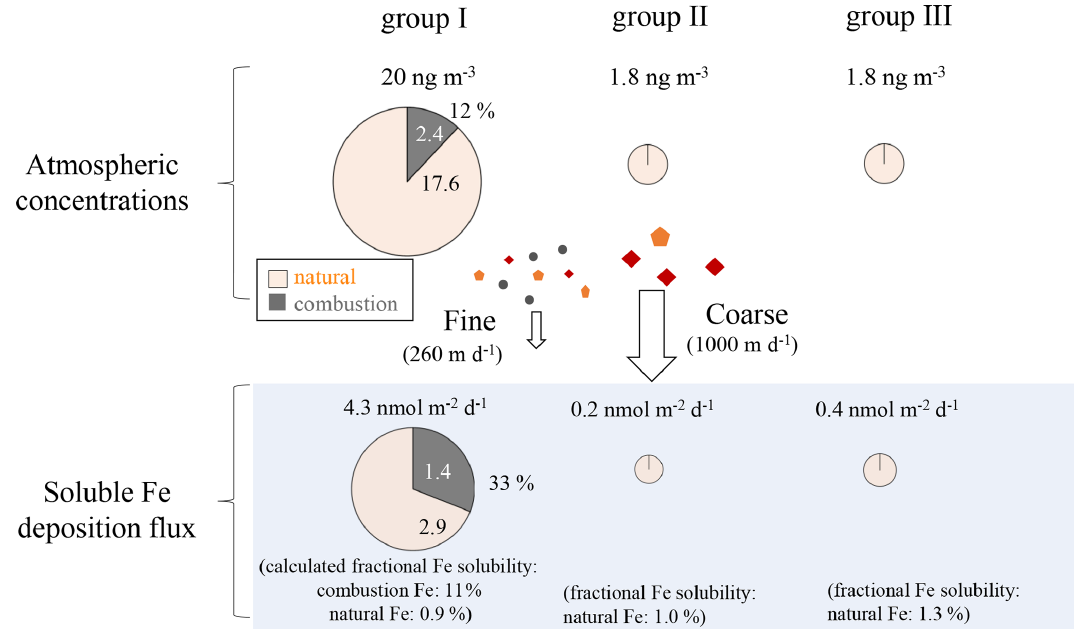
Figure 11. Summary of the contribution of combustion and natural Fe to atmospheric aerosols and soluble Fe depositions. The sizes of the pie charts are indicative of the magnitude of the atmospheric Fe concentrations and soluble Fe deposition